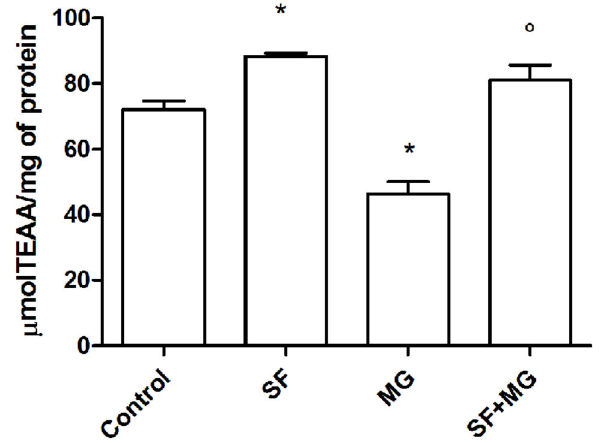
Figure 8. SF effects on cardiomyocytes total antioxidant activity. Cardiomyocytes were treated with 5 µM SF for 24 h before addition of 1 mM MG. Cell lysates were submitted to the ABTS radical cation decolorization assay and the antioxidant activity of the cells were expressed as mean ± SD of µmol of trolox antioxidant activity per mg of protein. p<0.05 vs Control; ° p<0.05 vs MG. doi: